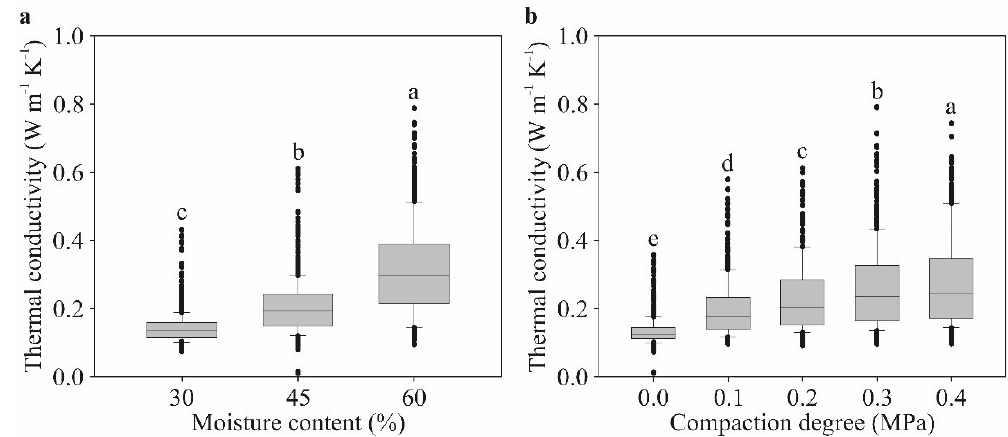
Figure 6. Variation in thermal conductivity ( k ) at different degrees of moisture content ( a , b ) dynamic compaction degree of compost bedding materials. Values followed by different letters are significantly different ( p < 0.05; Tukey).